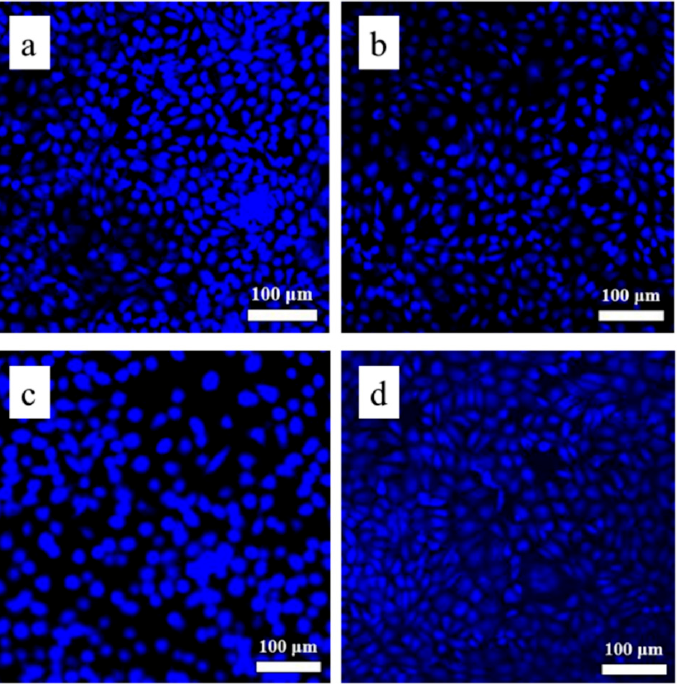
Figure 13. L929 cells’ morphology on ( a ) 316L/ HA 316L/HA, ( b ) as-printed 316L stainless steel, ( c ) as-cast 316L stainless steel and ( d ) TCPS (Tissue Culture Polystyrenes).